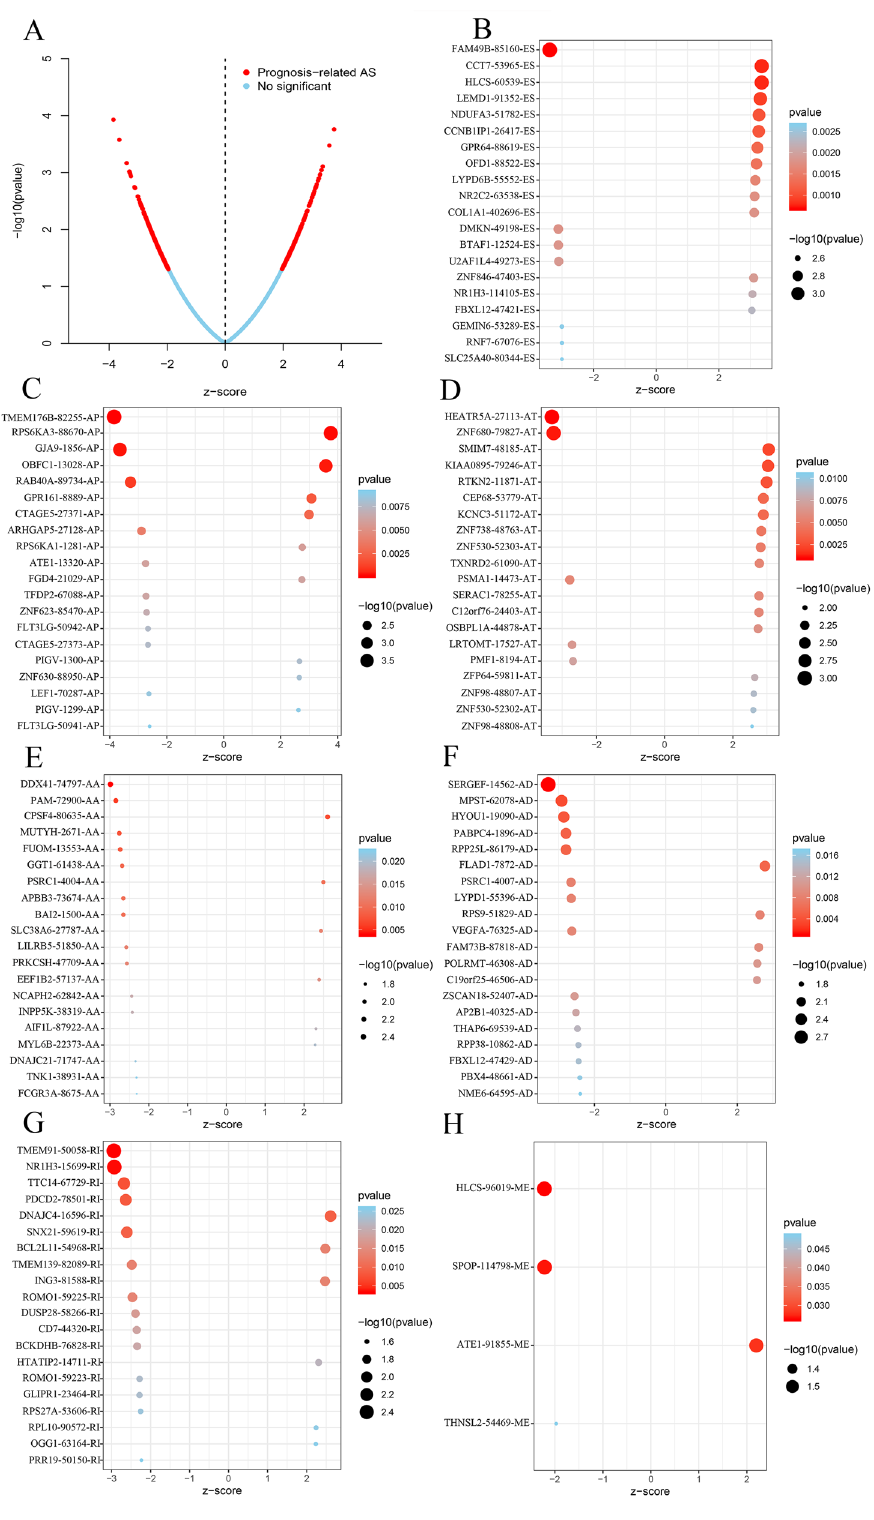
Figure 2. The significant AS events (top 20) in ovarian carcinoma. ( A ) The whole AS events in ovarian carcinoma patients. The red/blue dots showing AS events significantly/without related with prognosis. The top 20 AS events related with clinical outcome based on acceptor sites. The significant survival-related AS events in seven types, including ES ( B ), AP ( C ), AT ( D ), AA ( E ), AD ( F ), RI ( G ), and ME ( H